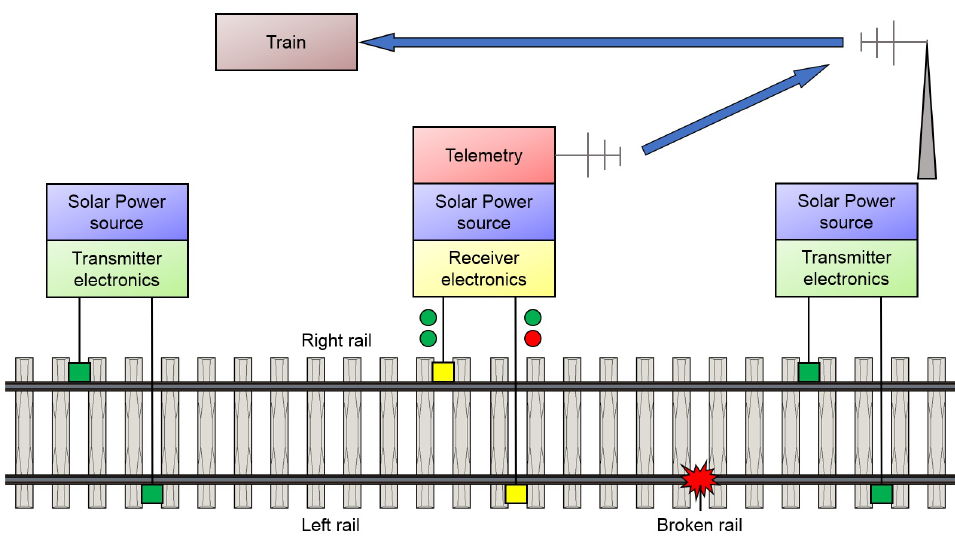
Figure 11. UBRD system concept